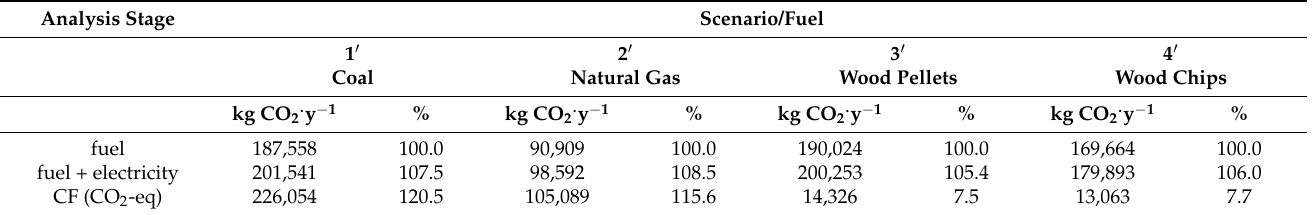
Table 9. Annual emissions of carbon dioxide and CF—comparison of the analysis stages; GH operation of 273 days, from February till